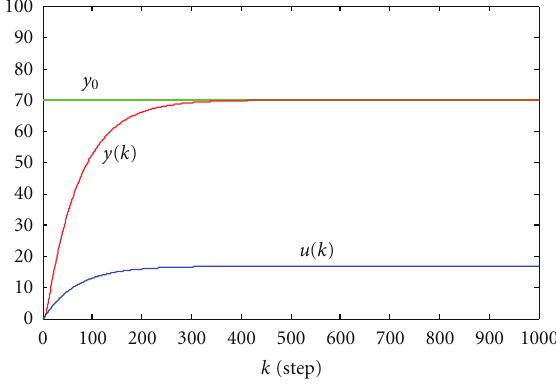
Figure 1: Control result of system (4).